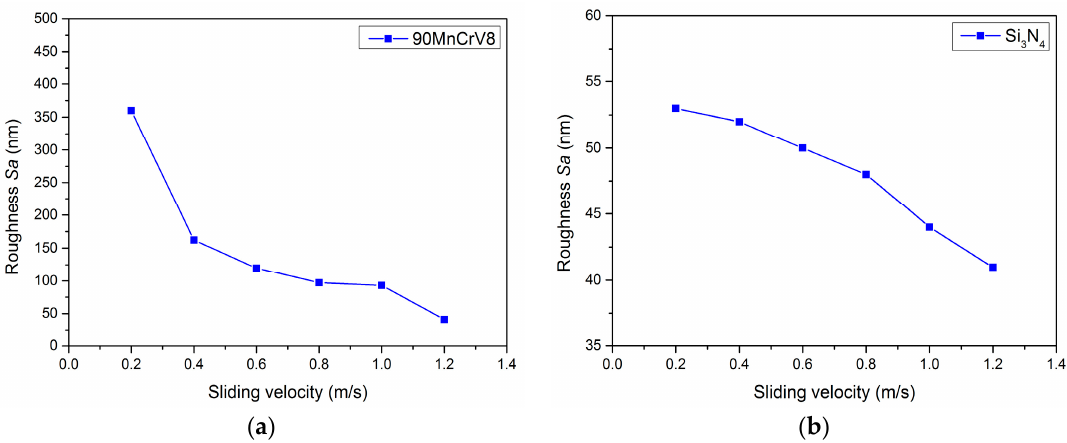
Figure 17. ( a ) Comparison of roughness of 90MnCrV8. ( b ) Comparison of roughness of Si 3 N 4